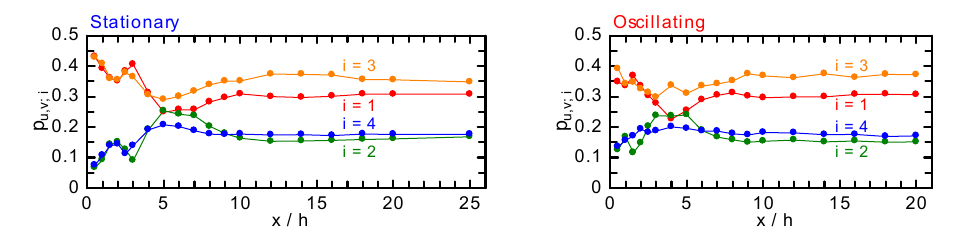
Fig. 10 Probability that the fluctuating velocity takes values of respective